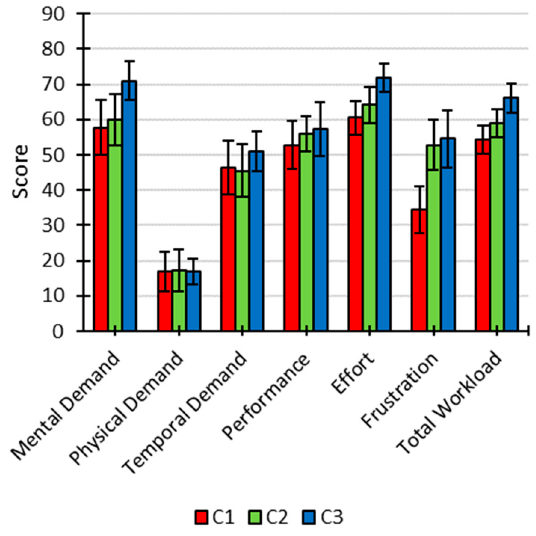
Figure 6. Scores (mean ± standard error) of total workload and unweighted six subdimensions for each condition (C1, no speech; C2, ignoring the speech; C3, attending to the speech) for NASA-TLX.